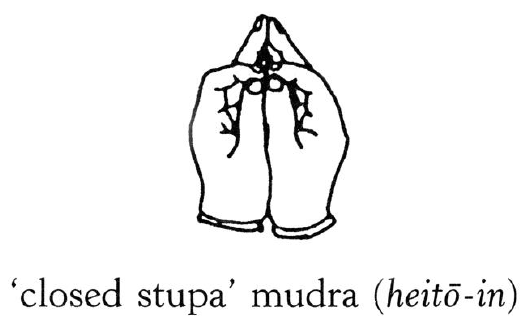
Figure 4. Heitō - in mudra. Reproduced from Inaya Yūsen, Shingon Shintō shūsei ; Seizansha, 1993.